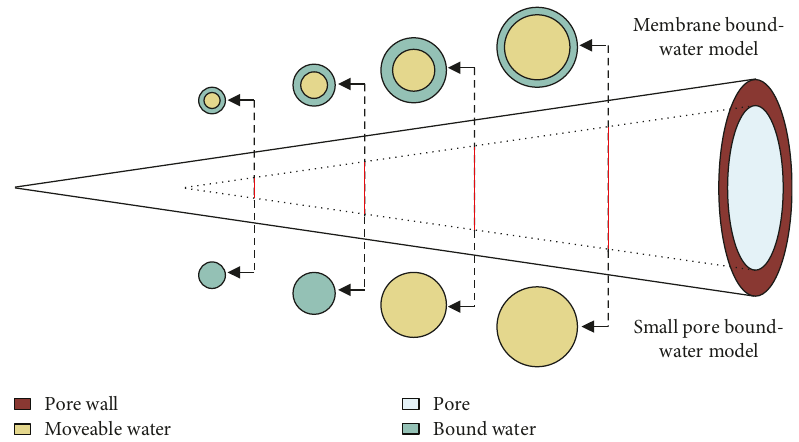
Figure 8: NMR bound-water